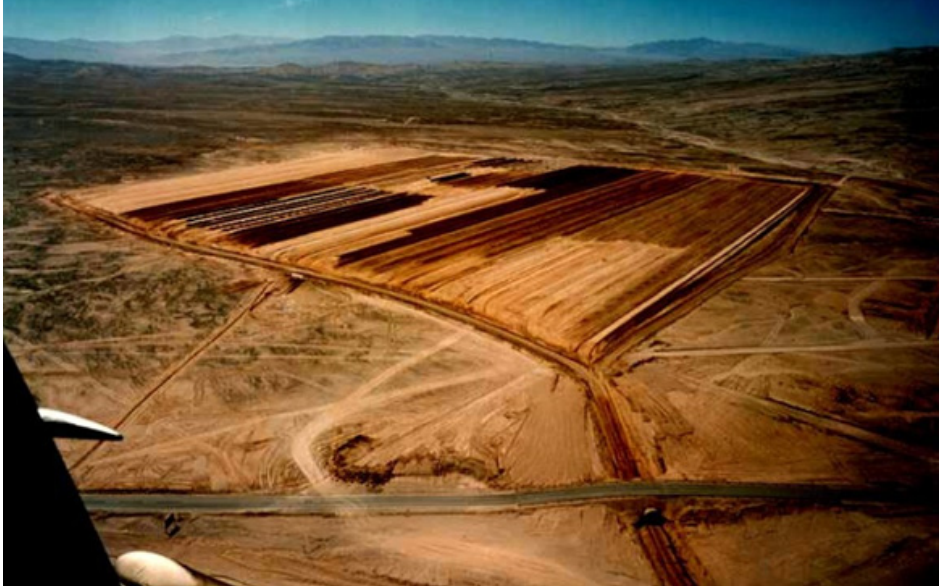
Figure 29. El Peñon Filtered Tailings Storage Facility Overview [62,63].